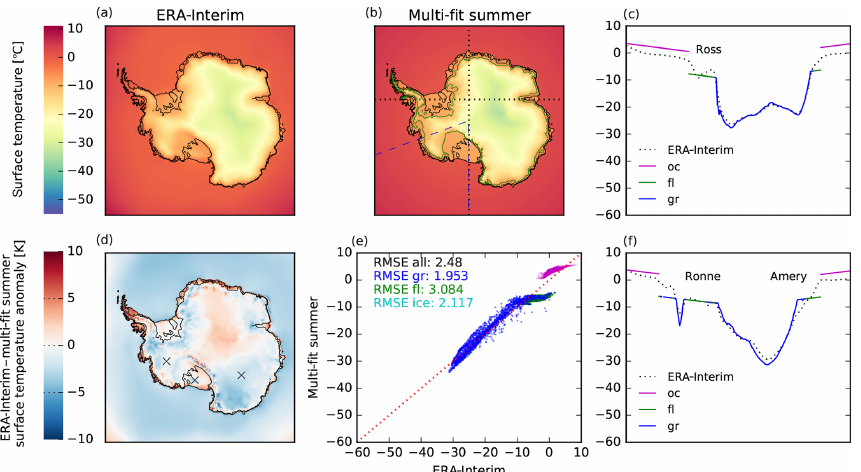
Figure 9. Comparison of ERA-Interim summer (January) mean temperatures with parameterization of Eq. (10). Root-mean-square errors of temperatures in grounded and floating ice sheet regions are 2.0 and 3.1K, respectively, with temperatures in the large ice shelves close to